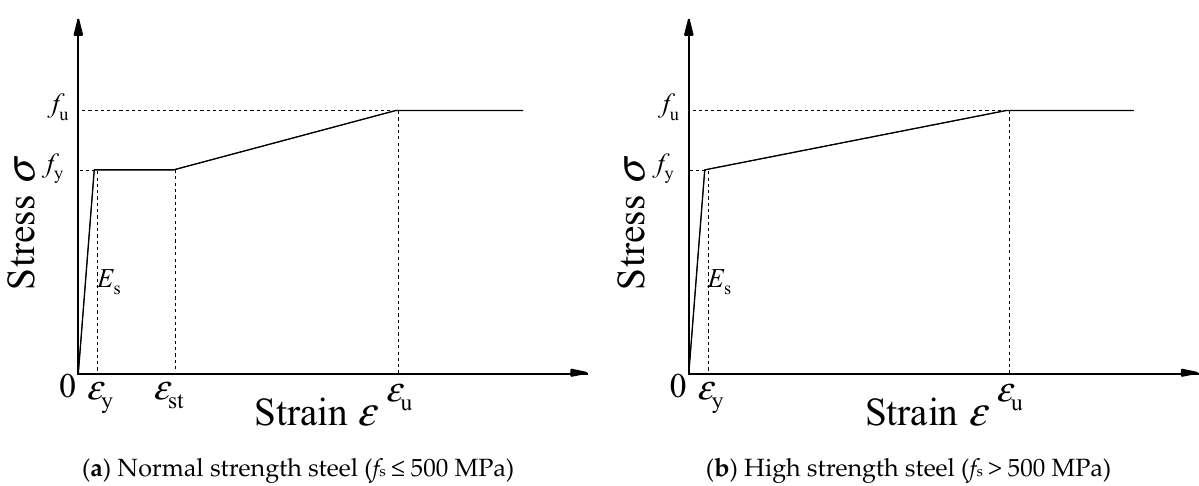
Figure 1. Uniaxial stress–strain curve of steel with or without yield plateau.